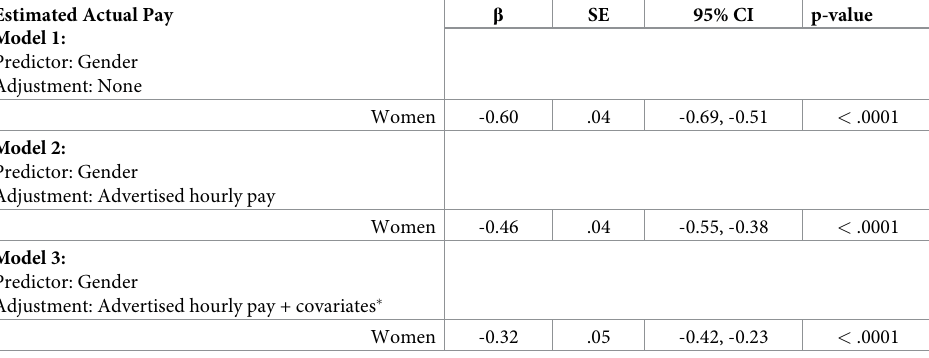
Table 2. Linear regression of estimated actual hourly pay on gender (N = 4,936,207). Estimated Actual Pay Model 1: